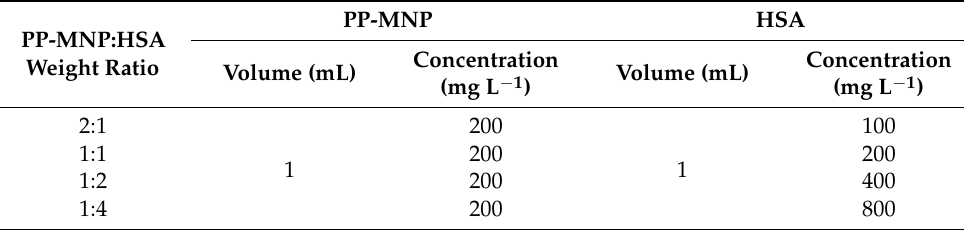
Table 1. Experimental concentration setup for the DLS/ELS